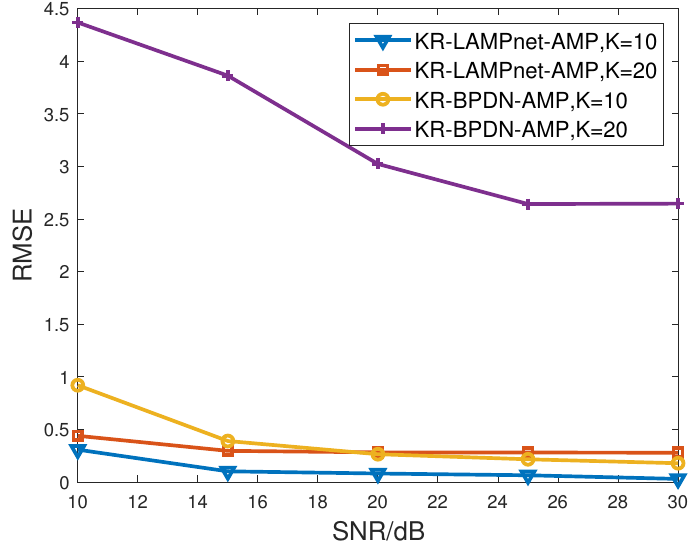
Figure 7. RMSE of the estimated